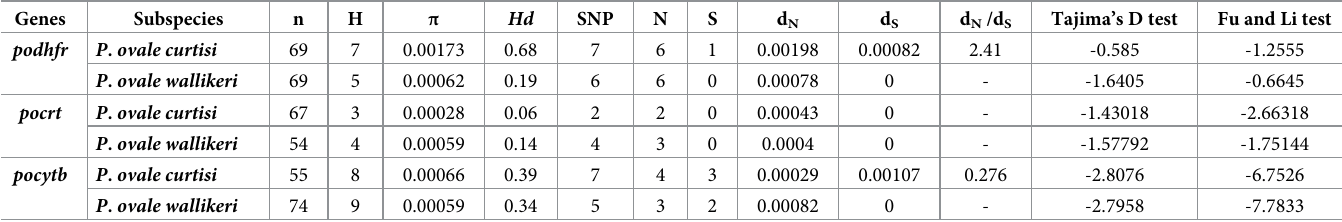
Table 3. Population genetics parameters of the podhfr , pocrt and pocytb in P . ovale curtisi and P . ovale wallikeri isolates.